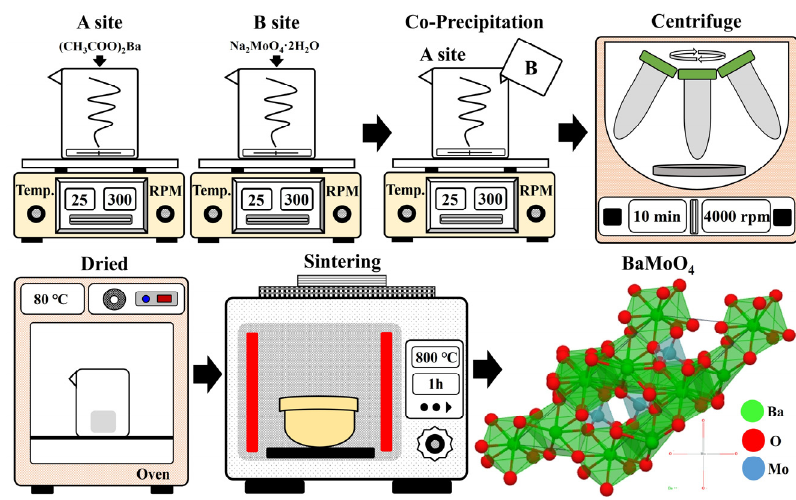
Figure 1. Experimental procedure for preparing the BaMoO 4 :[Er 3+ ]/[Yb 3+ ] up-conversion phosphors.